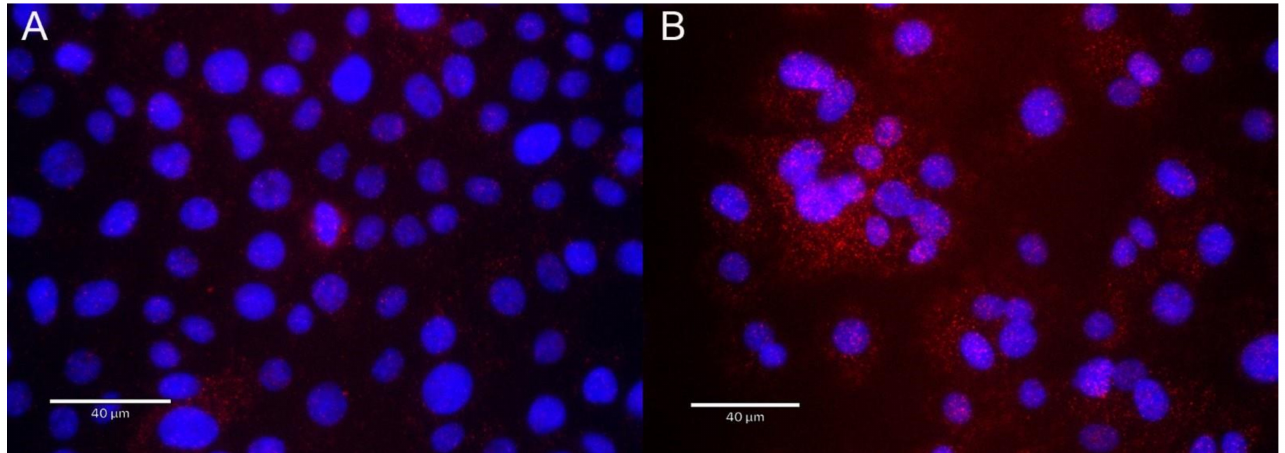
Figure 8. RELA · OGG1 complex formation is induced by RSV. Shown are PLAs for RELA · OGG1 complex in ( A ) control cells and ( B ) RSV-infected cells. Sites of protein–protein interactions (red foci) are nuclei of infected cells. Nuclei of cells are counter-stained with DAPI (blue). Note the intense staining in fused syncytia. Scale bar, 40 µ